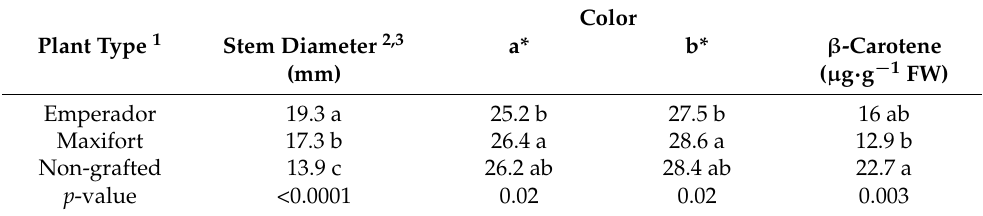
Table 2. Plant growth and fruit quality of tomato cultivars affected plant type in a high tunnel during the 2020 growing